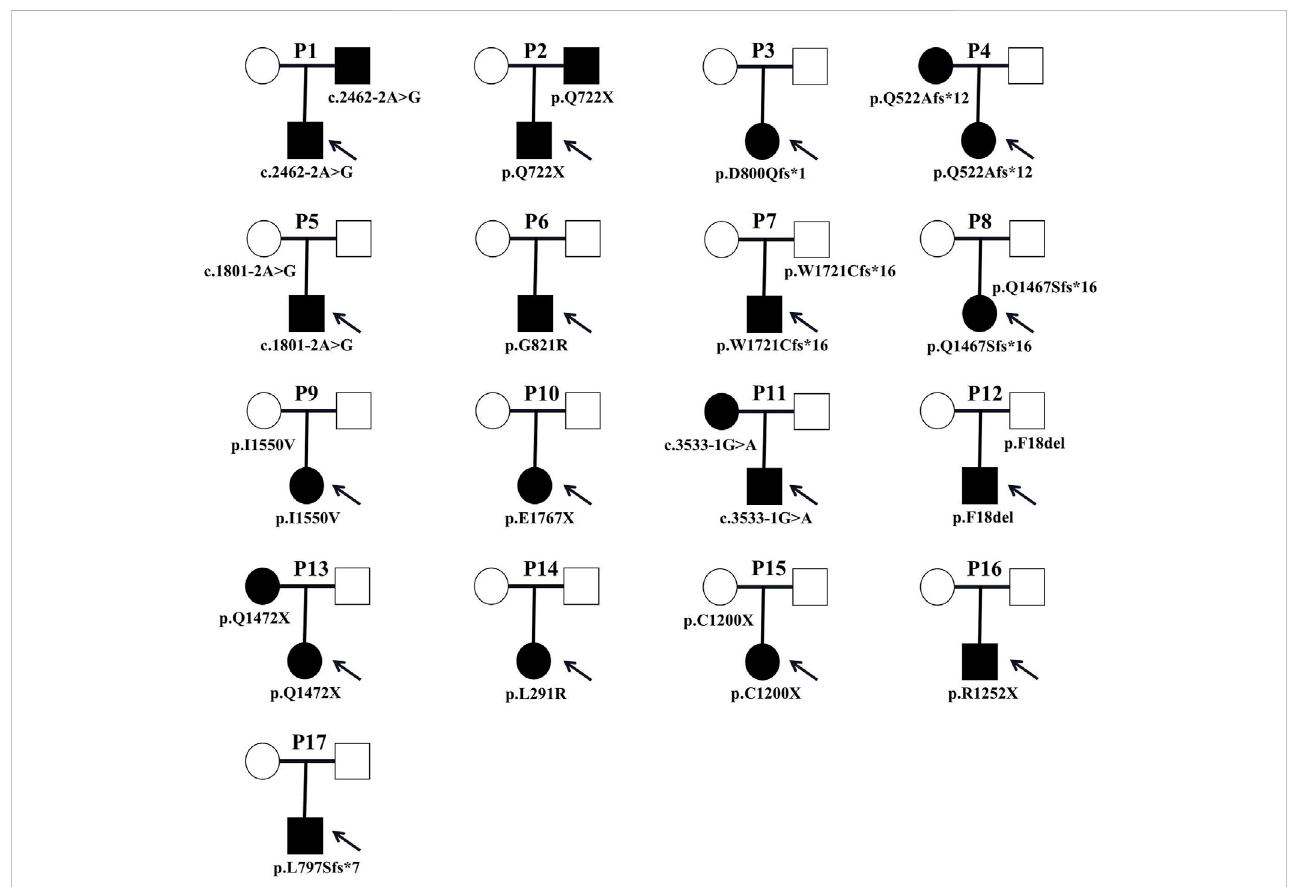
FIGURE 4 Pedigrees of affected families. Pedigrees of 17 families with ANK1 pathogenic variants. Probands are labeled by arrows. The proband and his father are labeled in the square, and the mother is labeled in the circle.